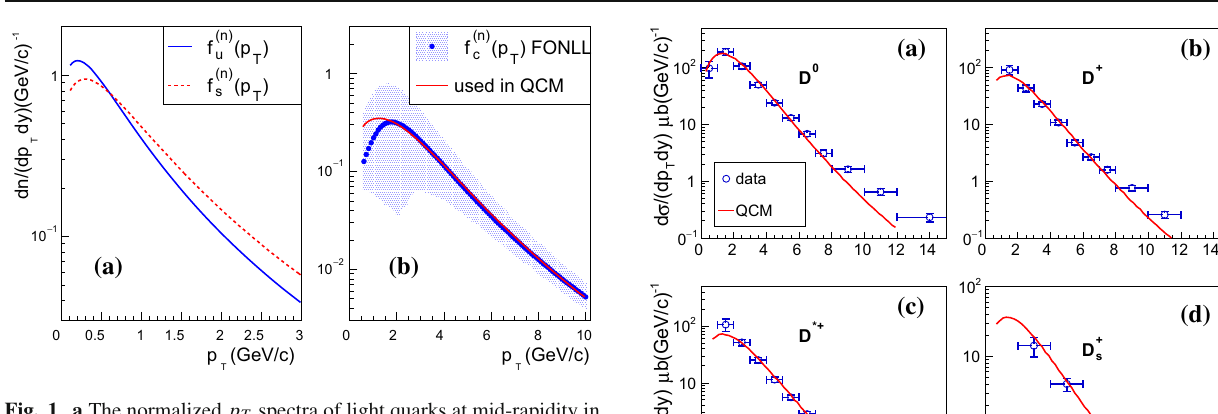
Fig.1a. The charge conjugation symmetry between quark and antiquark and the iso-spin symmetry between up and down quarks are applied in calculations.